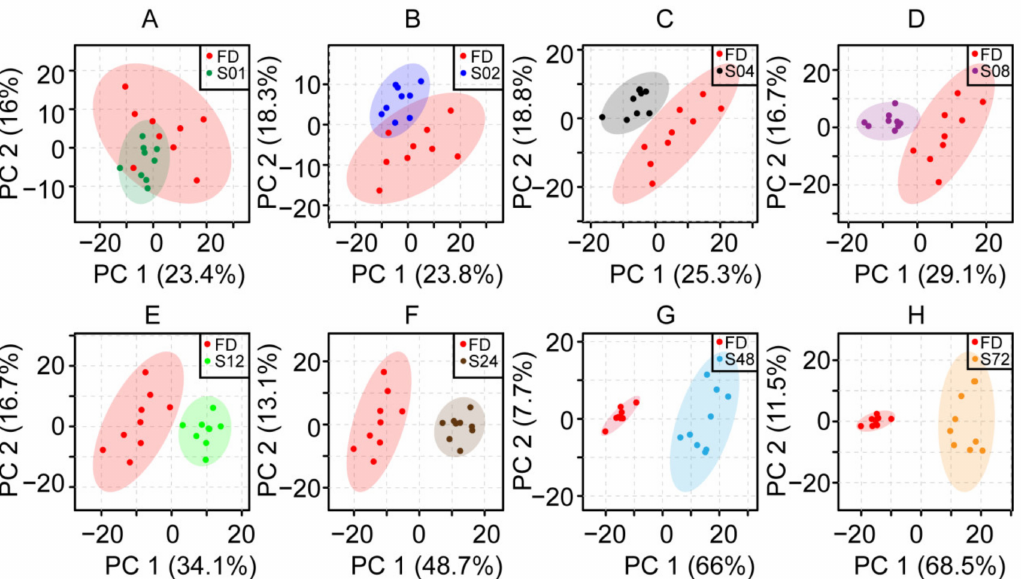
Figure 1. The PCA score plots of 2D 1 H- 13 C HSQC spectra of SR steamed for different durations. Comparison between the vacuum freeze-dried (FD, red) samples and samples steamed for ( A ) 1 (S01, green), ( B ) 2 (S02, blue), ( C ) 4 (S04, black), ( D ) 8 (S08, purple), ( E ) 12 (S12, light green), ( F ) 24 (S24, brown), ( G ) 48 (S48, light blue), and ( H ) 72 h (S72, yellow),